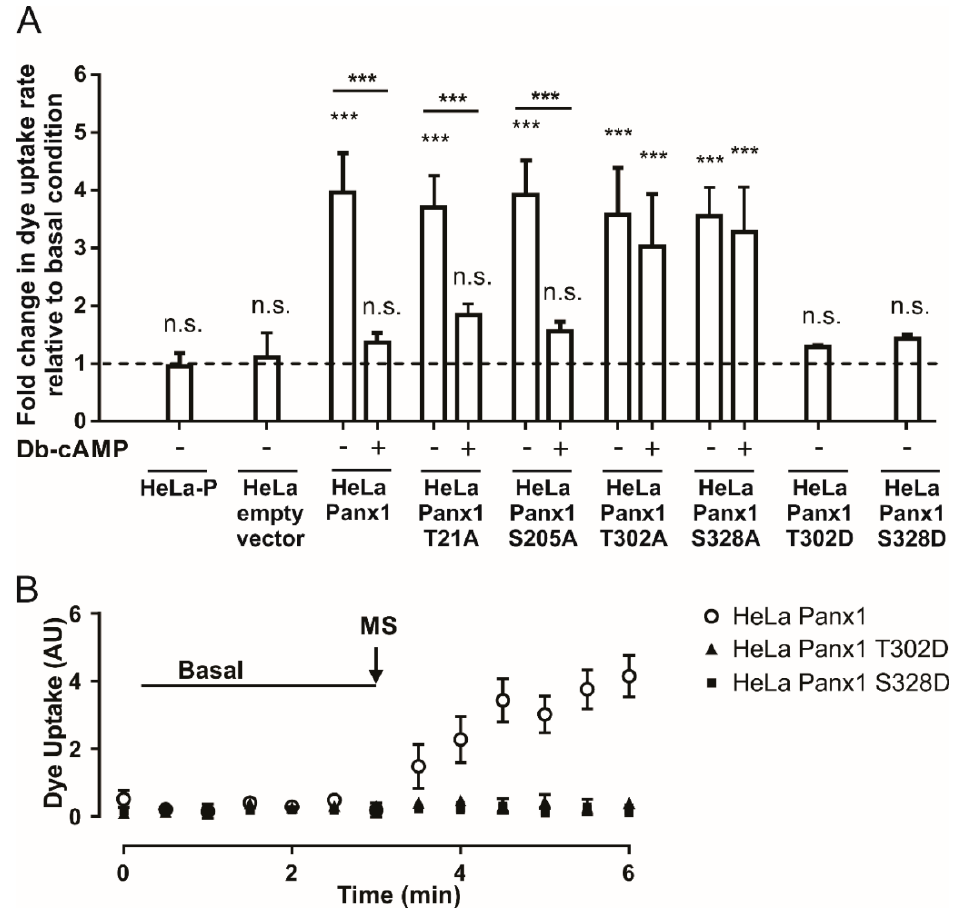
Figure 5. Phosphorylation in threonine 302 or serine 328 is necessary for the inhibition of Panx1 channels induced by Db-cAMP. ( A ) Normalized dye uptake rate in HeLa-P, HeLa-P transfected with pRK5 containing EGFP cDNA (EGFP empty vector), HeLa-Panx1-EGFP, or Hela transfected with Panx1 mutants (HeLa T21A, HeLa S205A, HeLa T302A, HeLa S328A, HeLa T302D and S328D) fused to EGFP subjected to mechanical stretch and subsequently treated with Db-cAMP. ( B ) Temporary course of DAPI uptake in HeLa-Panx1 cells transfected with Panx1-EGFP, Panx1 T302D-EGFP (Hela PanxT302D), or Panx1 S328D-EGFP (HeLa Panx328D) at basal condition and after mechanical stretch (MS, arrow). The dye uptake assay was performed 24 h post-transfection. Statistical analysis in ( A ) was performed between each experimental group (connecting lines), comparing each group with the baseline (symbols shown in each bar). Note: *** p < 0.001; n.s., not significant. Each value in ( A ) corresponds to the average ± standard error of a total of three to seven independent